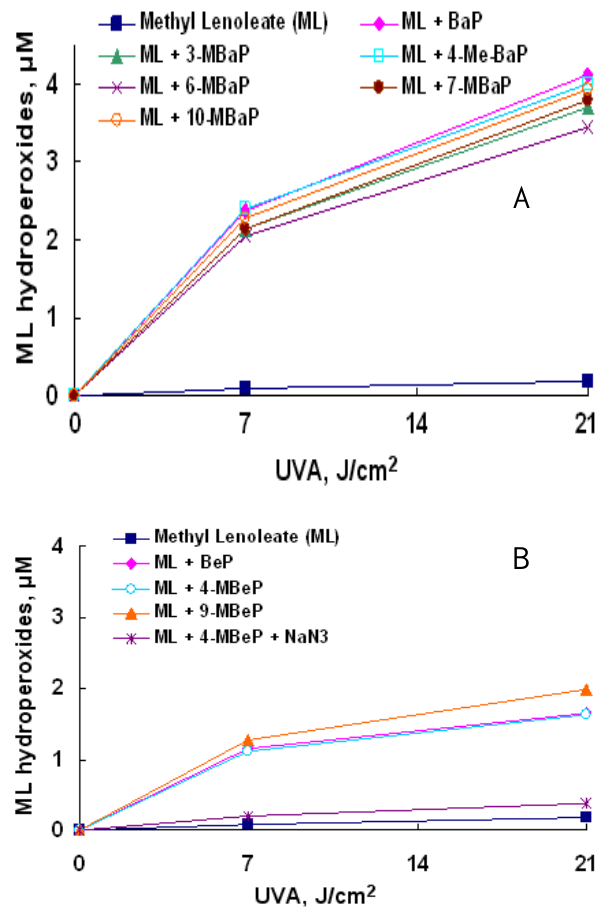
Figure 2: Peroxidation of methyl linoleate initiated by photoirradiation (with 0, 7, and 21 J/cm2 of UVA light) of BaP, 3-MBaP, 4-MBaP, 6-MBaP, 7-MBaP, and 10-MBaP (Upper Panel) and BeP, 4-MBeP, and 9-MBeP and photoirradiation of 4-MBeP in the presence of NaN (Lower Panel).